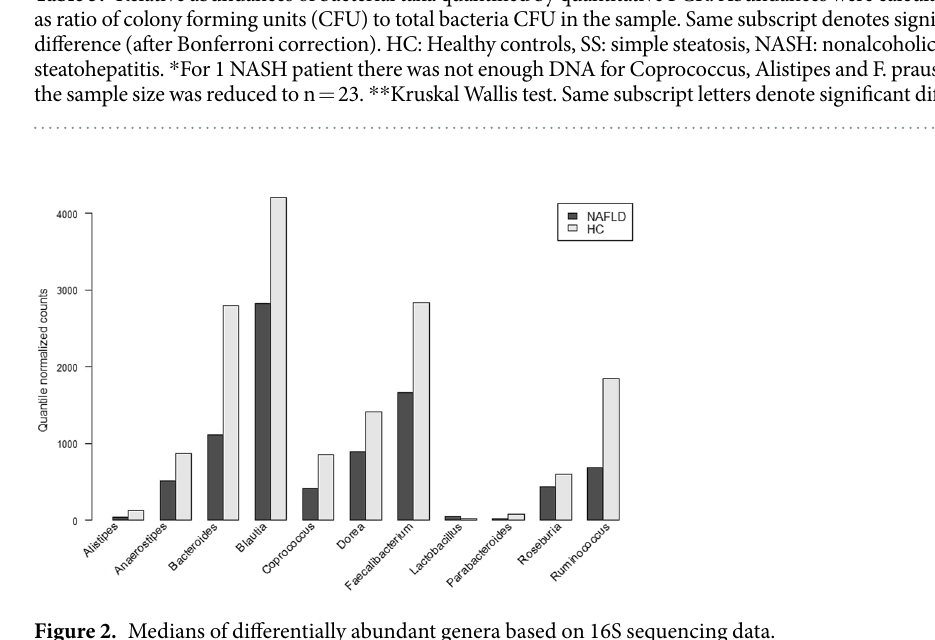
Figure 2. Medians of differentially abundant genera based on 16S sequencing data.